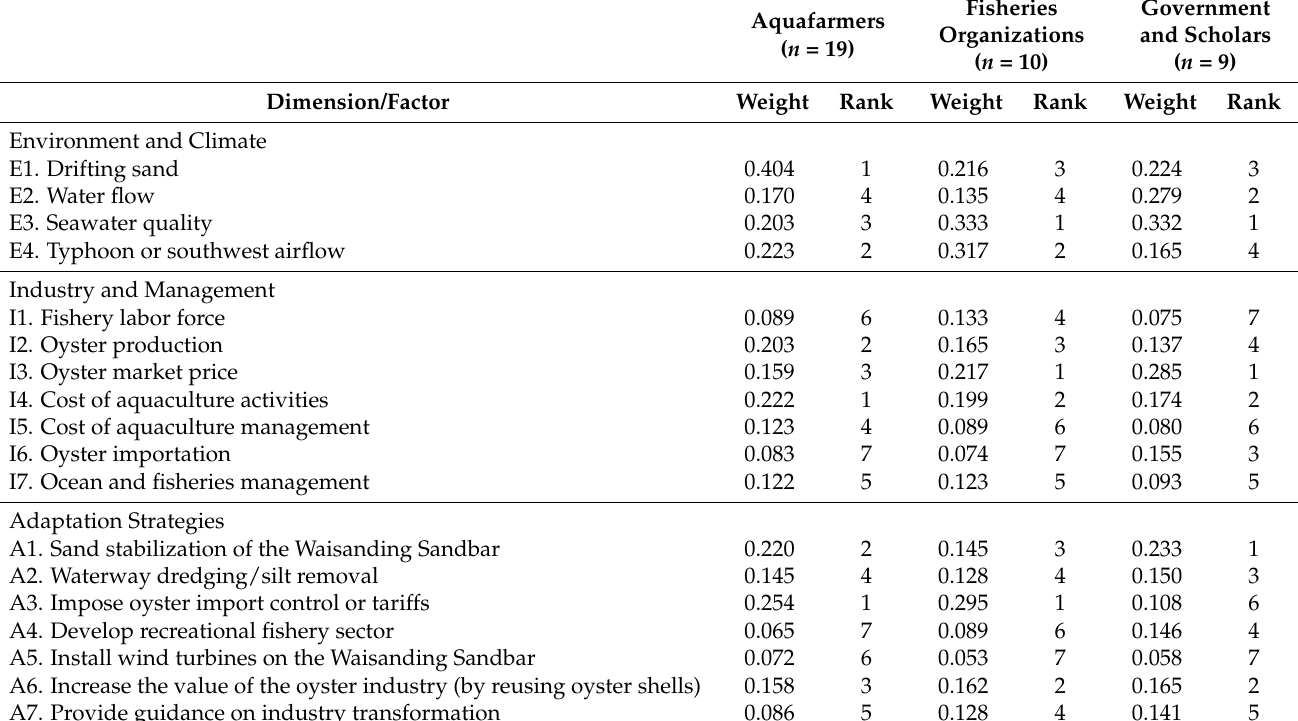
Table 2. Analysis of AHP questionnaire